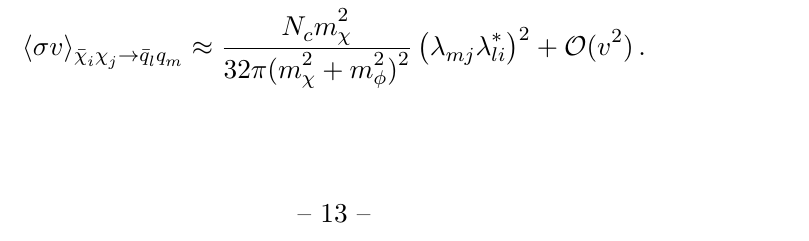
Figure 6 . The DD bounds for three coupling choices | (cid:31) to c , and (cid:31) to t . Bounds for LUX (CDMSlite) are solid (dashed), and the (cid:12)lled region shows the 3 parameters which give the correct relic abundance. Constraints are based on the dominant tree level contribution to